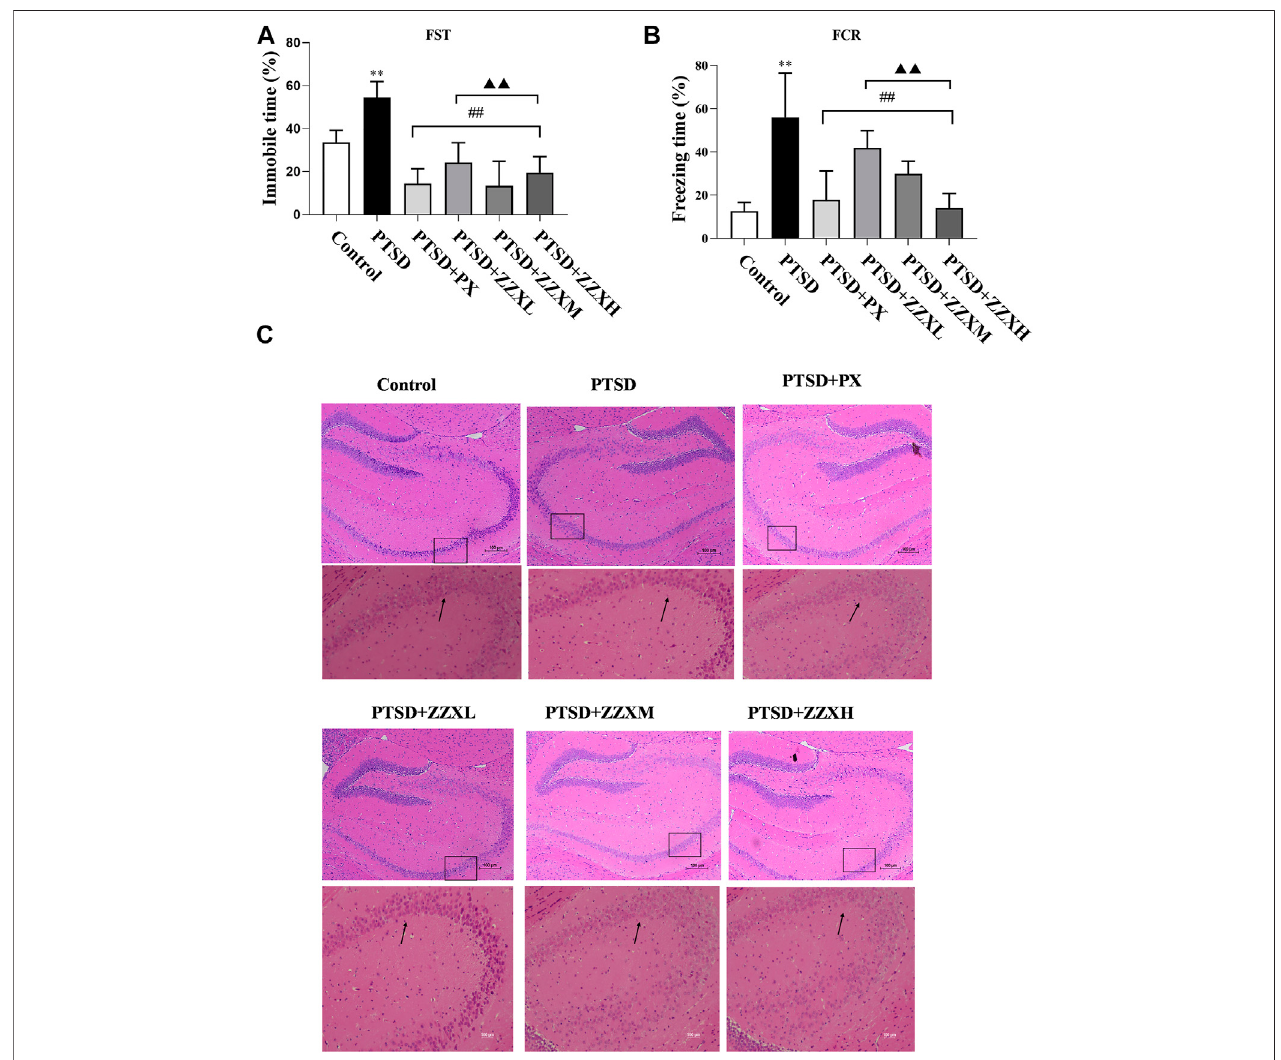
FIGURE 4 | Effect of ZZX on FST, FCR, and pathological changes in hippocampus CA1 region of mice. (A) Immobile time in the FST; (B) freezing time in the FCR; (C) hematoxylin – eosin(HE)staining(magni fi cation: × 200,above;magni fi cation: × 400,below).Valuesareexpressedas(mean ± SEM, n (cid:2) 10 – 15).* p < 0.05,** p < 0.01vs control group. # p < 0.05, ## p < 0.01 vs PTSD group. ▲ p < 0.05, ▲▲ p < 0.01 vs ZZXM